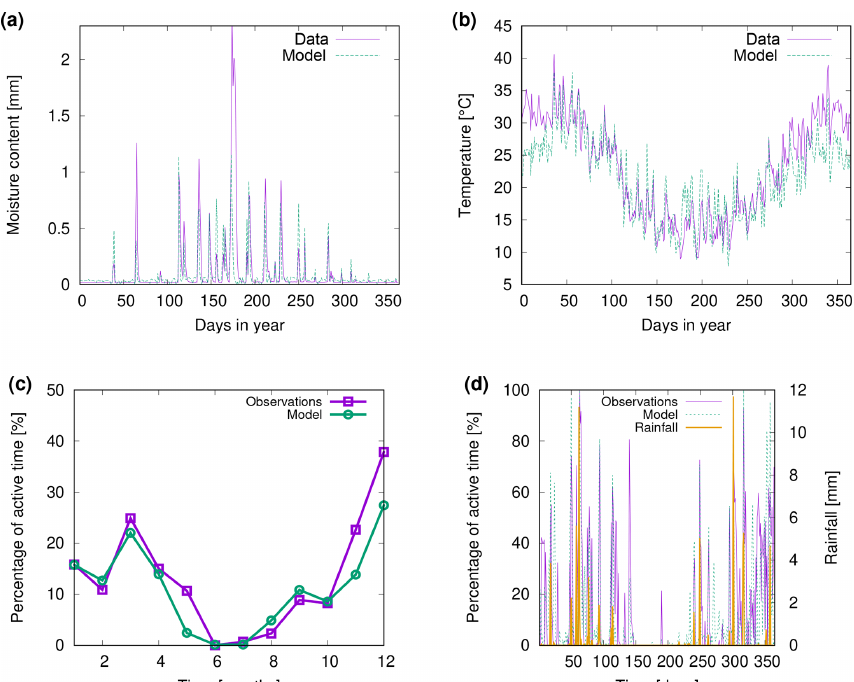
Figure 10. Comparison of (a) biocrust water content and (b) surface temperature estimated by LiBry to observations for one field site (number 4) and one biocrust type (dark cyanobacteria-dominated biocrust) at Soebatsfontein, South Africa. Comparison of (c) monthly and (d) daily biocrust active time fraction simulated by LiBry to observations from a field site near Almería, southern